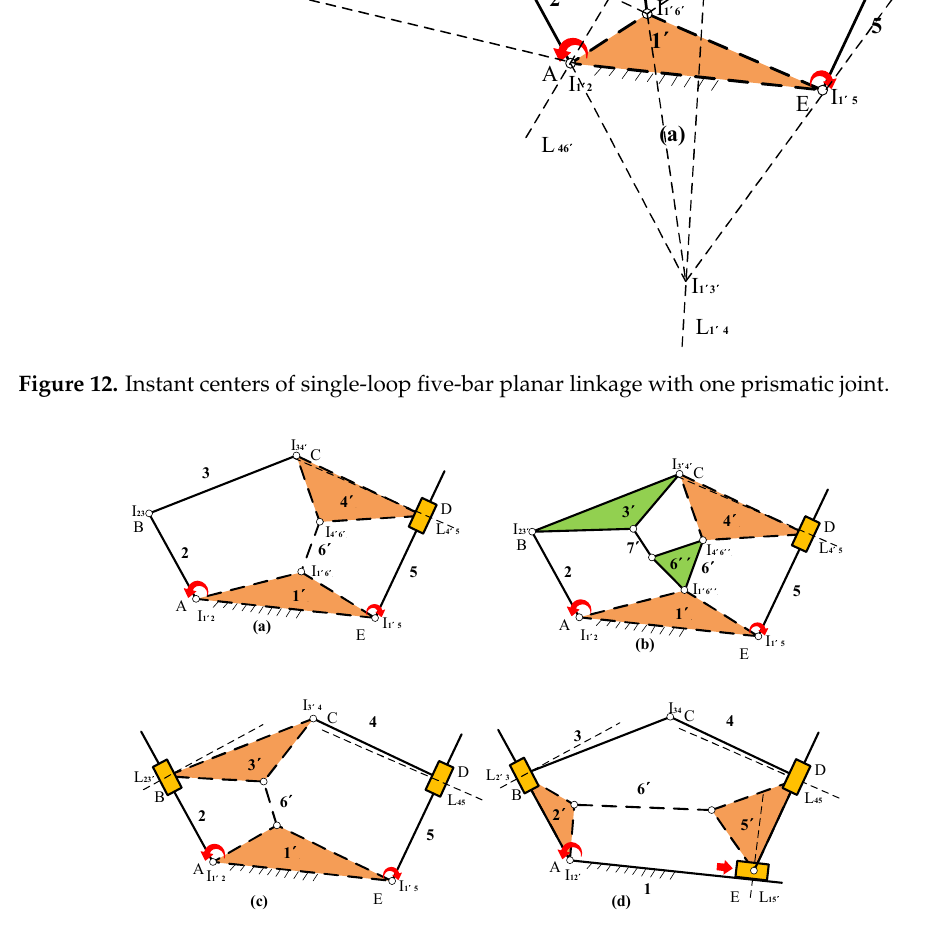
Figure 13. Single-loop five-bar planar linkage with ( a ) one prismatic joint and virtual links 1’, 4’, 6’, ( b ) one prismatic joint and virtual links 1’, 3’, 4’, 6’’, 7’ using iterative configuration, ( c ) two pris- matic joints and virtual links 1’, 3’, 6’, ( d ) three prismatic joints and virtual links 2’, 5’, 6’.